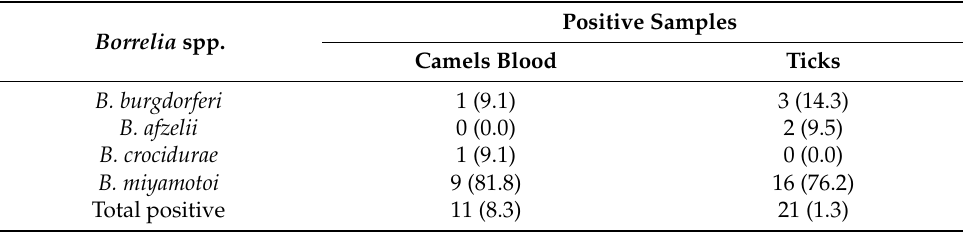
Table 3. Prevalence of Borrelia species in camel blood samples and ticks. Borrelia spp.